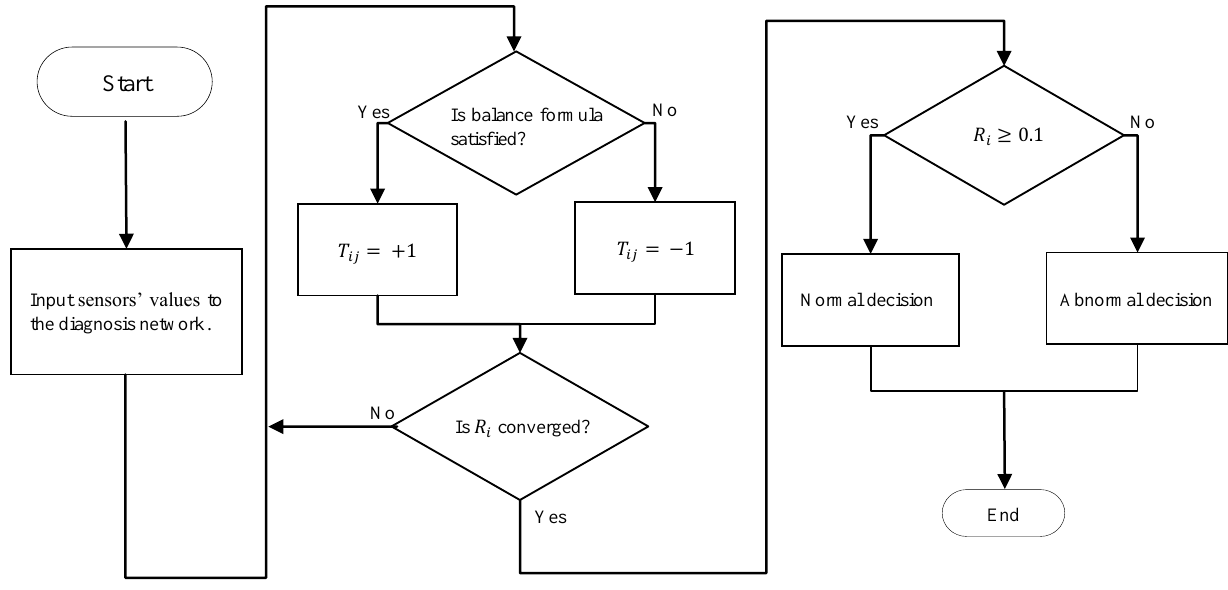
Figure 1. Flowchart of the diagnostic